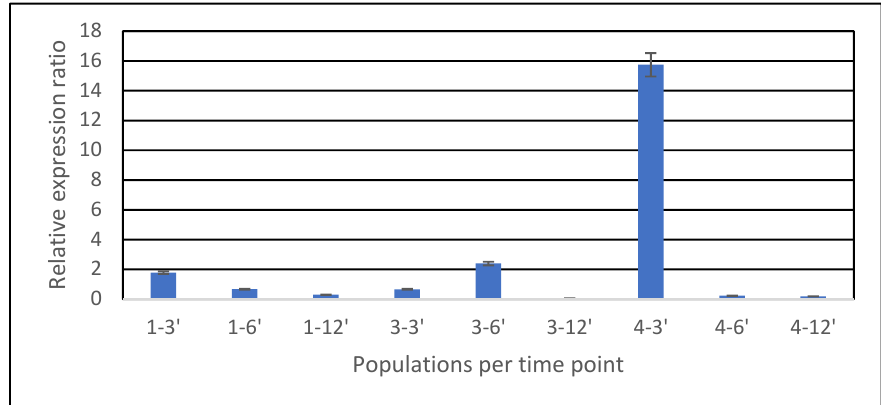
Figure 7. Relative expression ratio of the LpM10 gene for the populations 1, 3 and 4 in glyphosate- applied leaves (3, 6 and 12 h after glyphosate application).